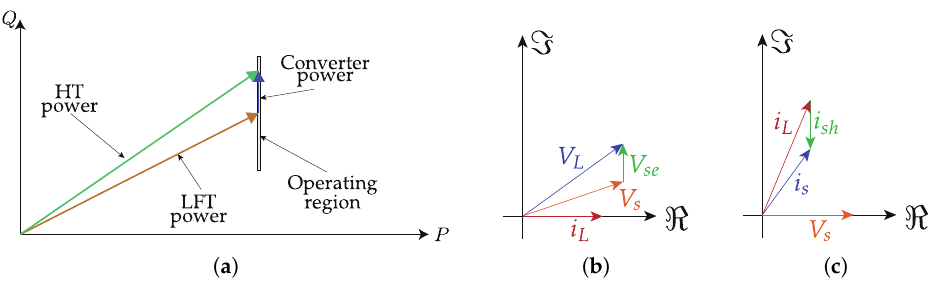
Figure 11. Operating region of HDTs whose power converters inject reactive power, exclusively. ( a ) Ac- tive and reactive power (PQ) operating region. ( b ) Series voltage injection. ( c ) Shunt current injection.